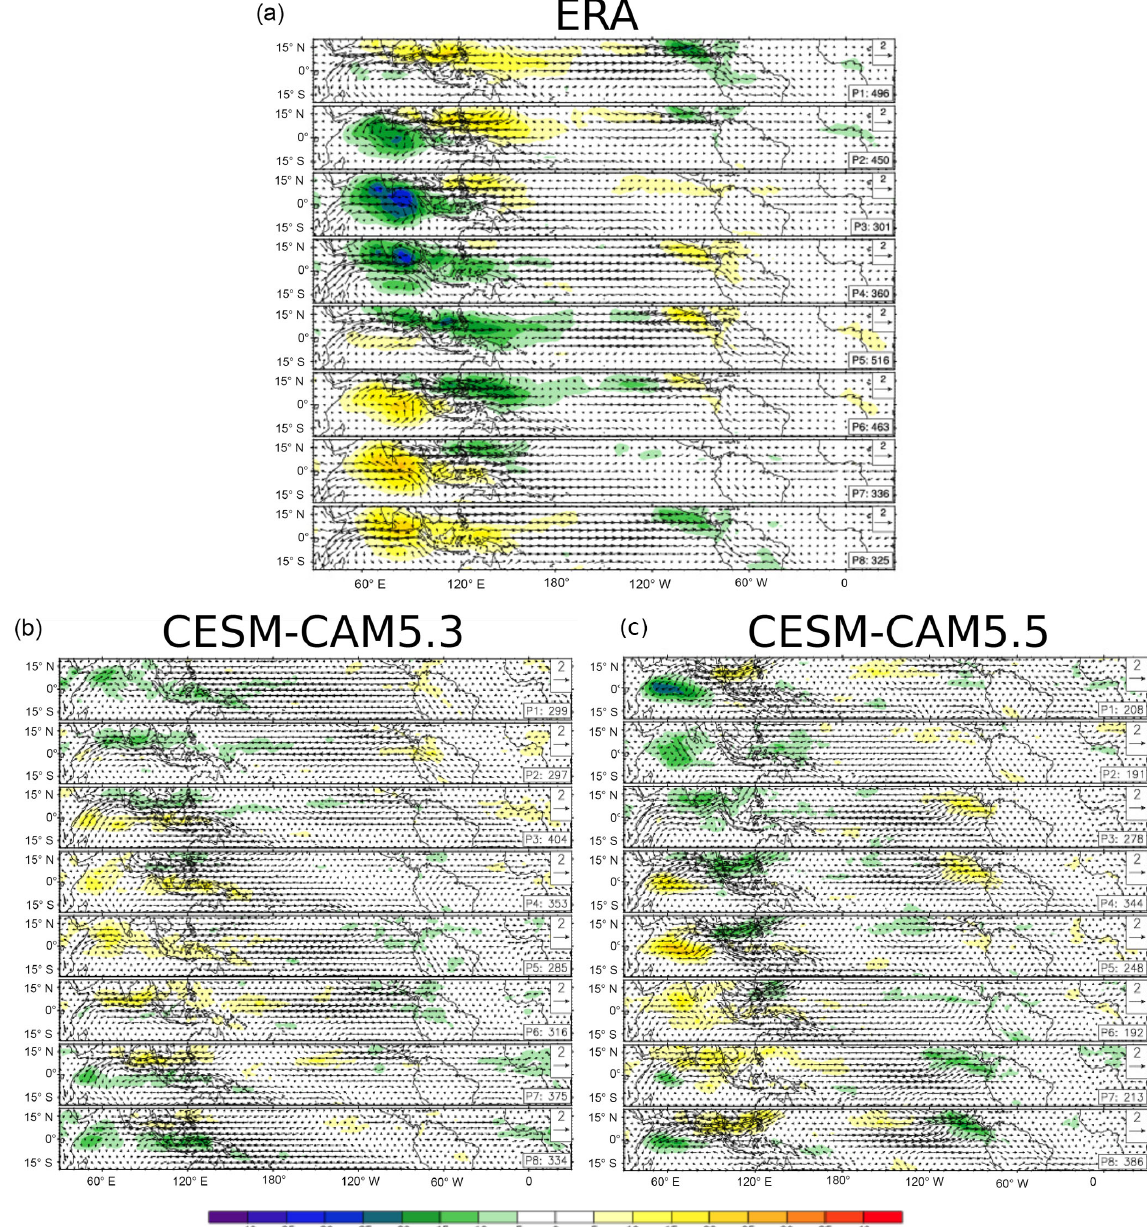
Figure 14. The composite of the 20- to 100-day bandpass-filtered daily anomalies of OLR (color) and wind vectors at 850hPa during boreal winter (November through April) for ERA-Interim (a) , CESM-CAM5.3 (b) , and CESM-CAM5.5 (c)